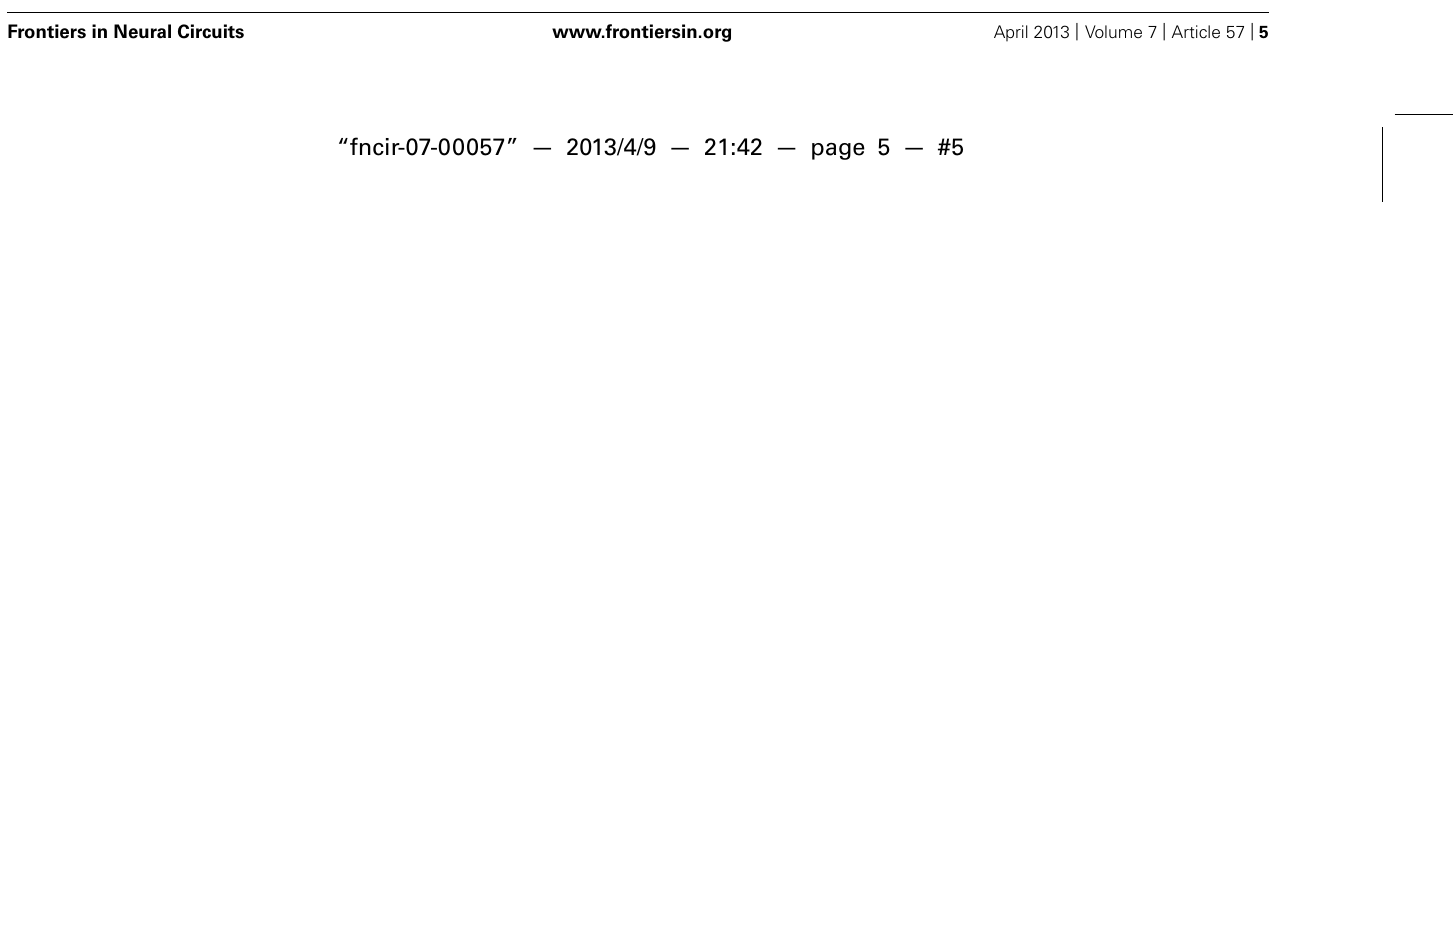
FIGURE 2 | Output effects evoked by intraspinal stimulation. (A) Electrical stimuli were delivered to a single intraspinal electrode while the monkey performed a two-dimensional wrist task, acquiring targets in wrist flexion and extension. (B) Muscle responses evoked by a single pulse at 90 μ A.The vertical scale bar at right indicates mean percent increase (MPI) over baseline.